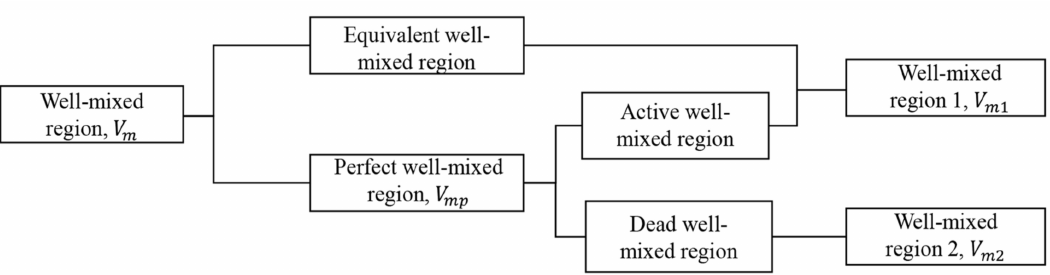
Figure 9. Tundish mixing area [54]. © 2018 WILEY-VCH Verlag GmbH & Co. KGaA, Weinheim All rights